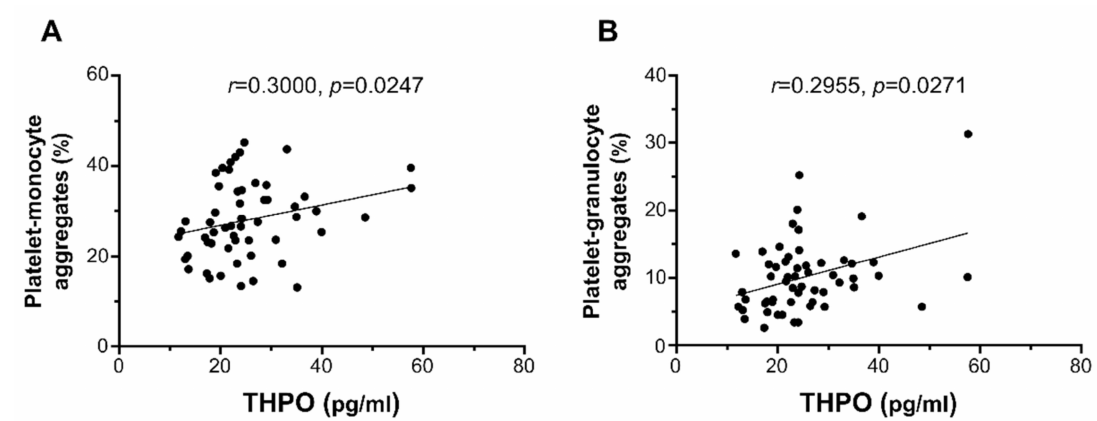
Figure 3. Correlation of THPO plasma levels with ex vivo platelet–monocyte ( A ) and platelet–granulocyte ( B ) aggregates. Analyses by Spearman correlation tests; correlation coefficient r- and p -values are